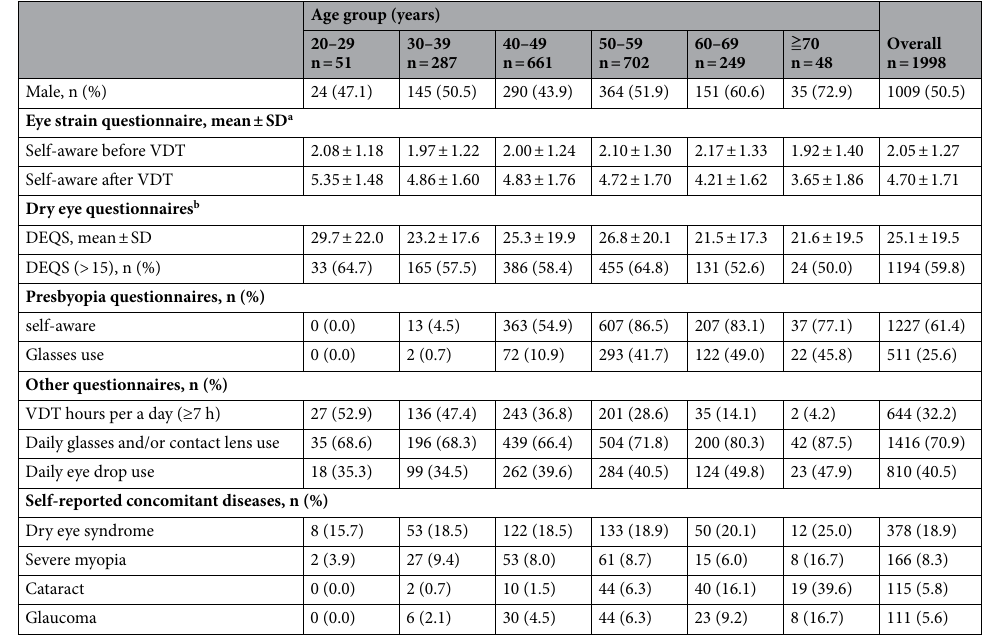
Table 1. Characteristics of participants in this study. This is a relatively older population, but it can be seen to cover all age groups to some extent. a It is simulated to responses before and after the VDT task by setting conditions of eye use. b Based on the dry eye-related quality-of-life score QOL (DEQS) questionnaires 42 , participants who were likely positive for dry eye syndrome were screened at a cutoff of > 15 DEQS 43 . SD standard